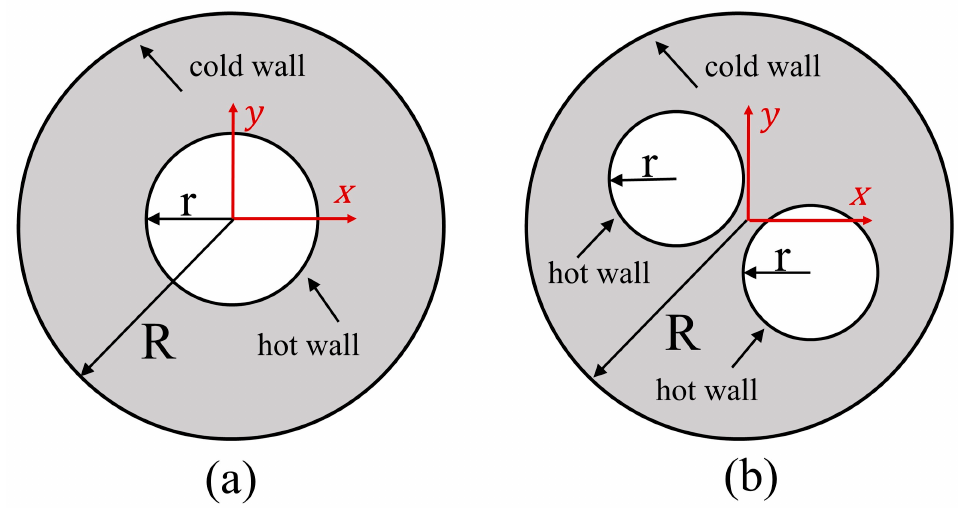
Figure 1. Representative geometry: ( a ) single inner-ring annulus; ( b ) double inner-ring annulus. All the geometries are meshed with Gmsh and simulated in OpenFOAM. Then, the obtained temperature field and the Nu number field are considered as the basis to guide the training of the